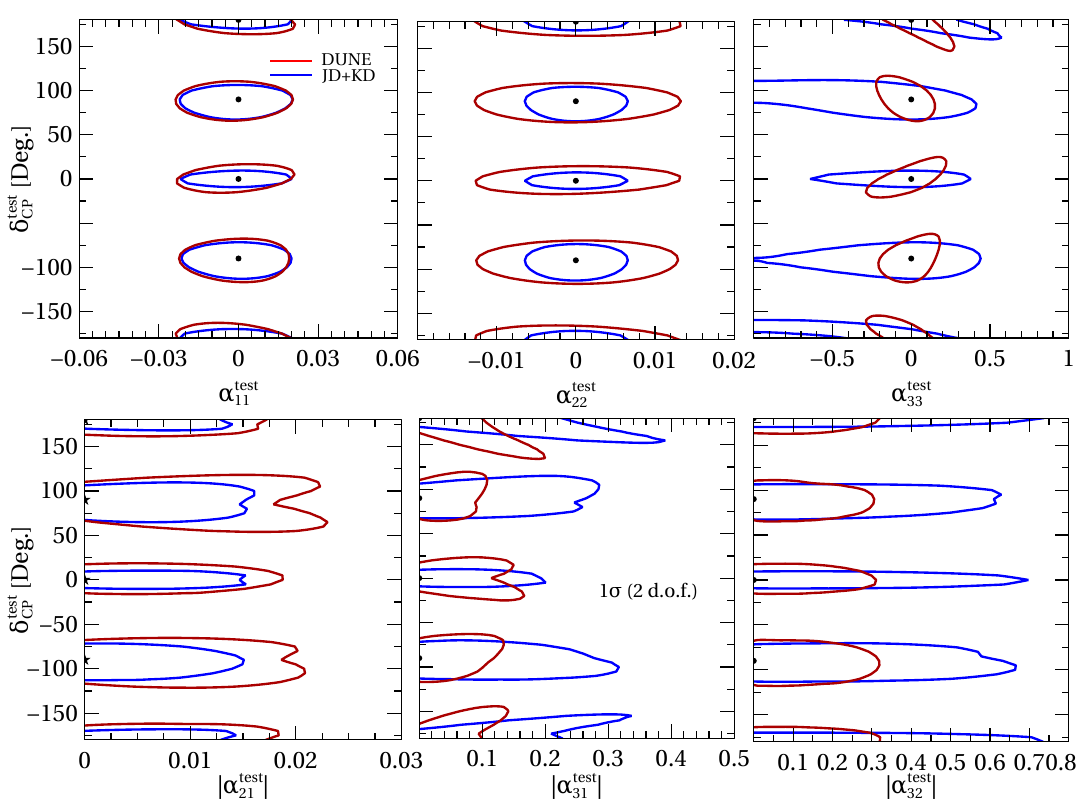
Figure 5 . 1 σ (2 d.o.f.) C.L. contours in the ( δ CP - α ij ) planes for DUNE (red curves) and JD+KD (blue curves). The true values of δ considered here are δ = 0 ◦ , 90 ◦ , 180 ◦ , − 90 ◦ (shown by the CP CP black dots in each panel). The true value of θ is 45 ◦ , while its test value is kept free in the range 23 [ 40 ◦ , 50 ◦ ]. In the fit, the phases associated with off-diagonal NUNM parameters (see lower panels) are marginalized over the range of [- 180 ◦ , 180 ◦ ]. The other oscillation parameters are fixed at the values as given in table